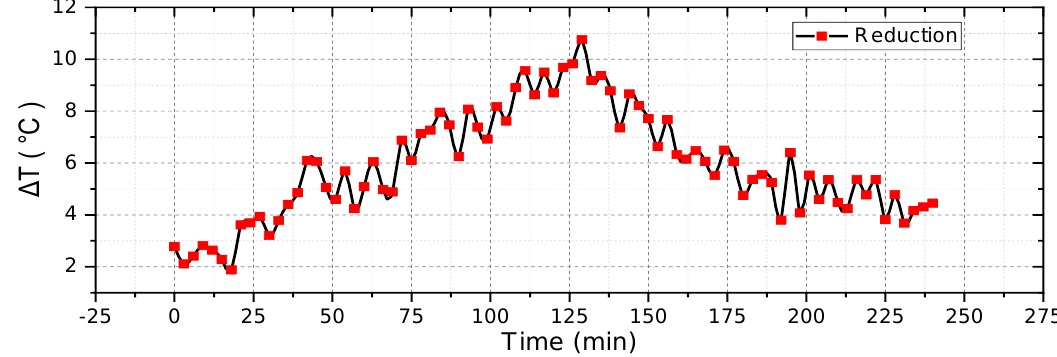
Figure 9. Δ𝑇 reduction for each of NL-TEG and L-TEG systems.